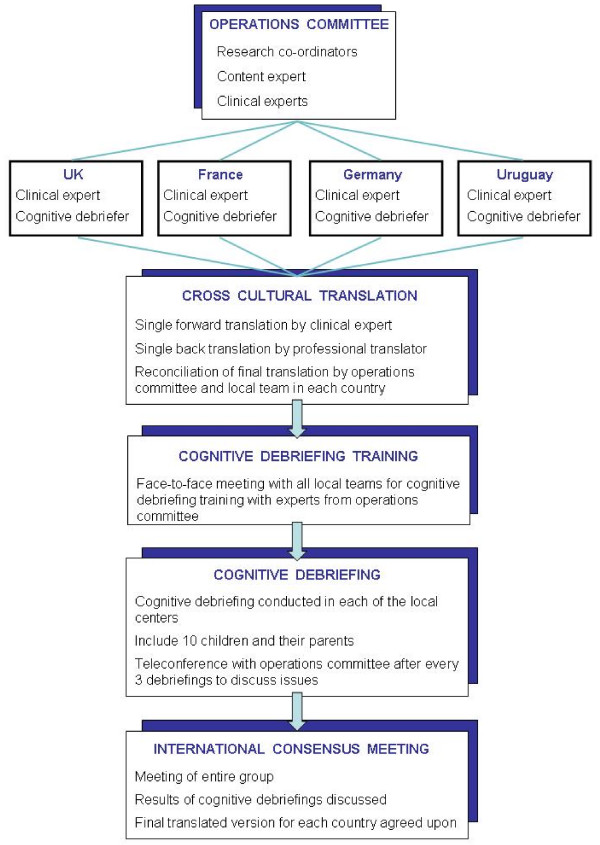
The cross-cultural translation process of the KIT.